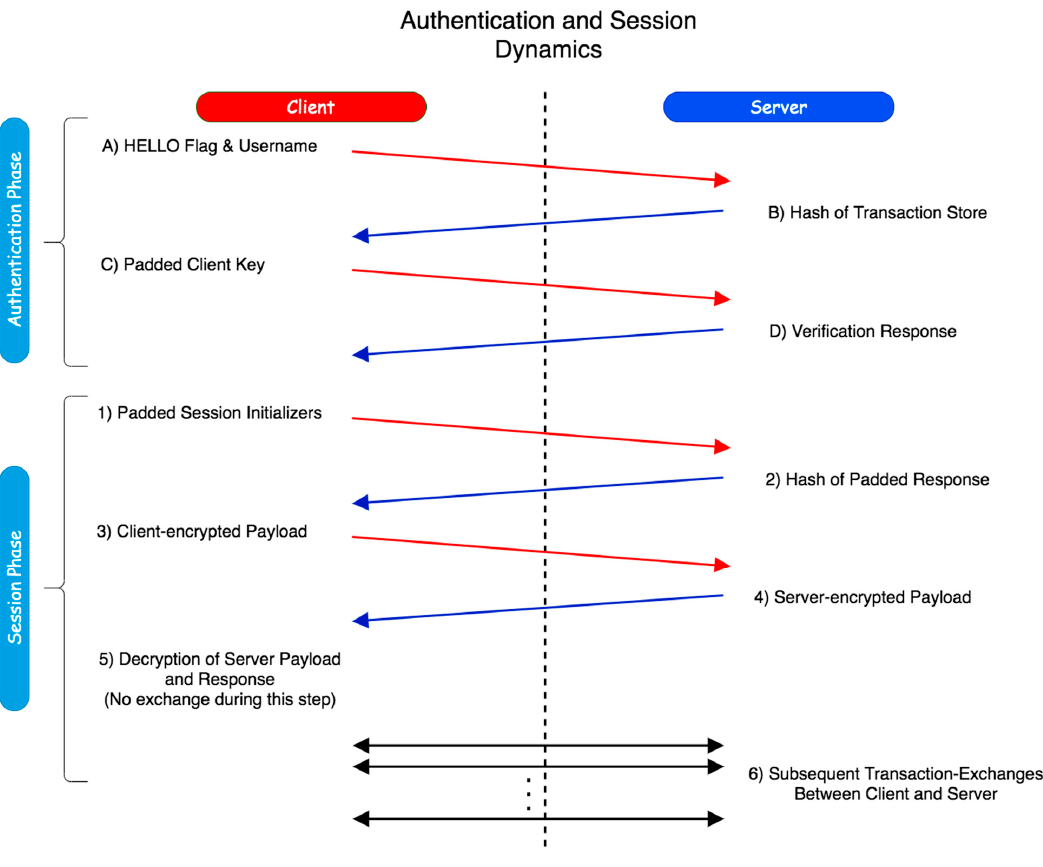
Figure 1. Dynamics of the proposed model.